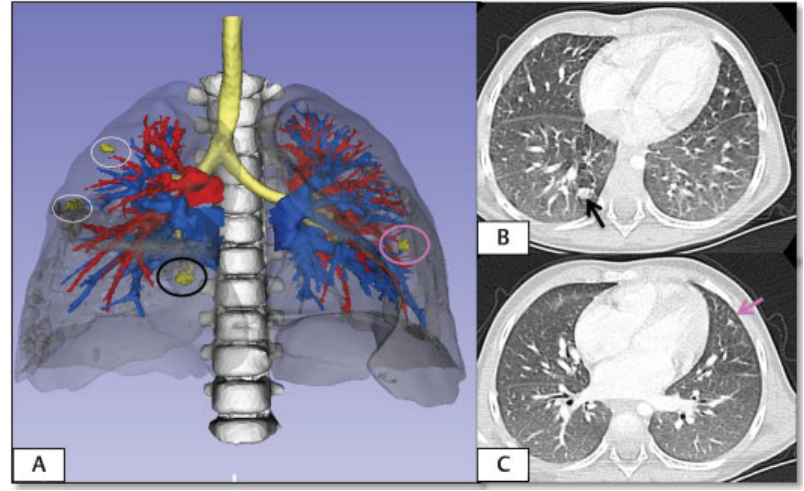
Fig. 4 Case 2. ( A ) Three-dimensional reconstruction performed from the preoperative CT. There are three metastases in the right lung and one in the leftone. ( B and C ) Cross-sections of thethoracic CT. Lesionsmarkedby arrow correspond tothosemarked with the same color in the virtual reconstruction. CT, computed